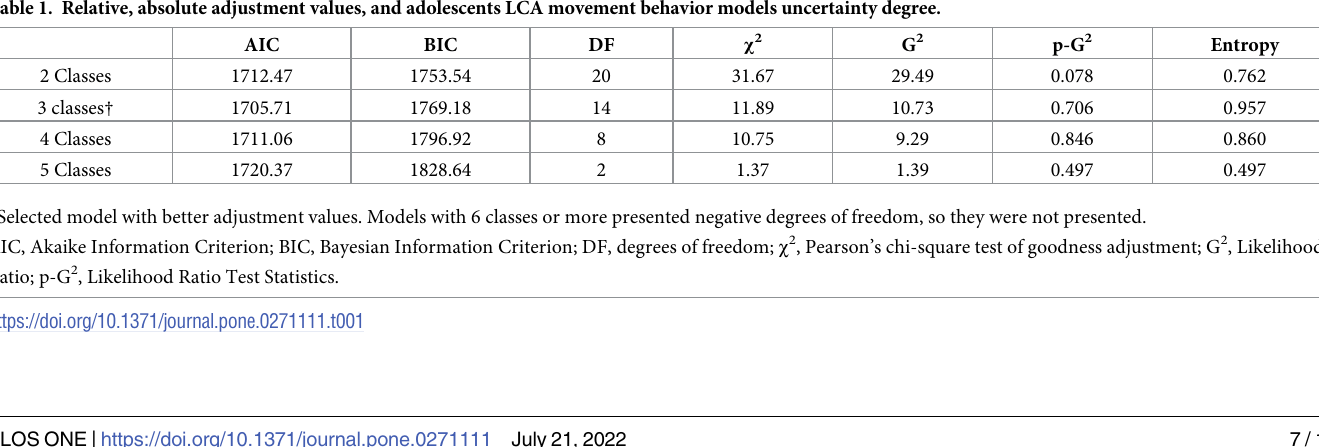
Table 2 presented the associations of individual correlates (biological, lifestyle habits, and psychological) between latent classes and movement behaviors. No associations were found between classes 1 and 2 when individual covariates were analyzed. Between classes 1 and 3, it was observed that participants with low fruit intake, low CRF, and stressed, when compared to their peers (high fruit intake, high CRF and no stress), had respectively, 7.17 (95% CI: 1.64–